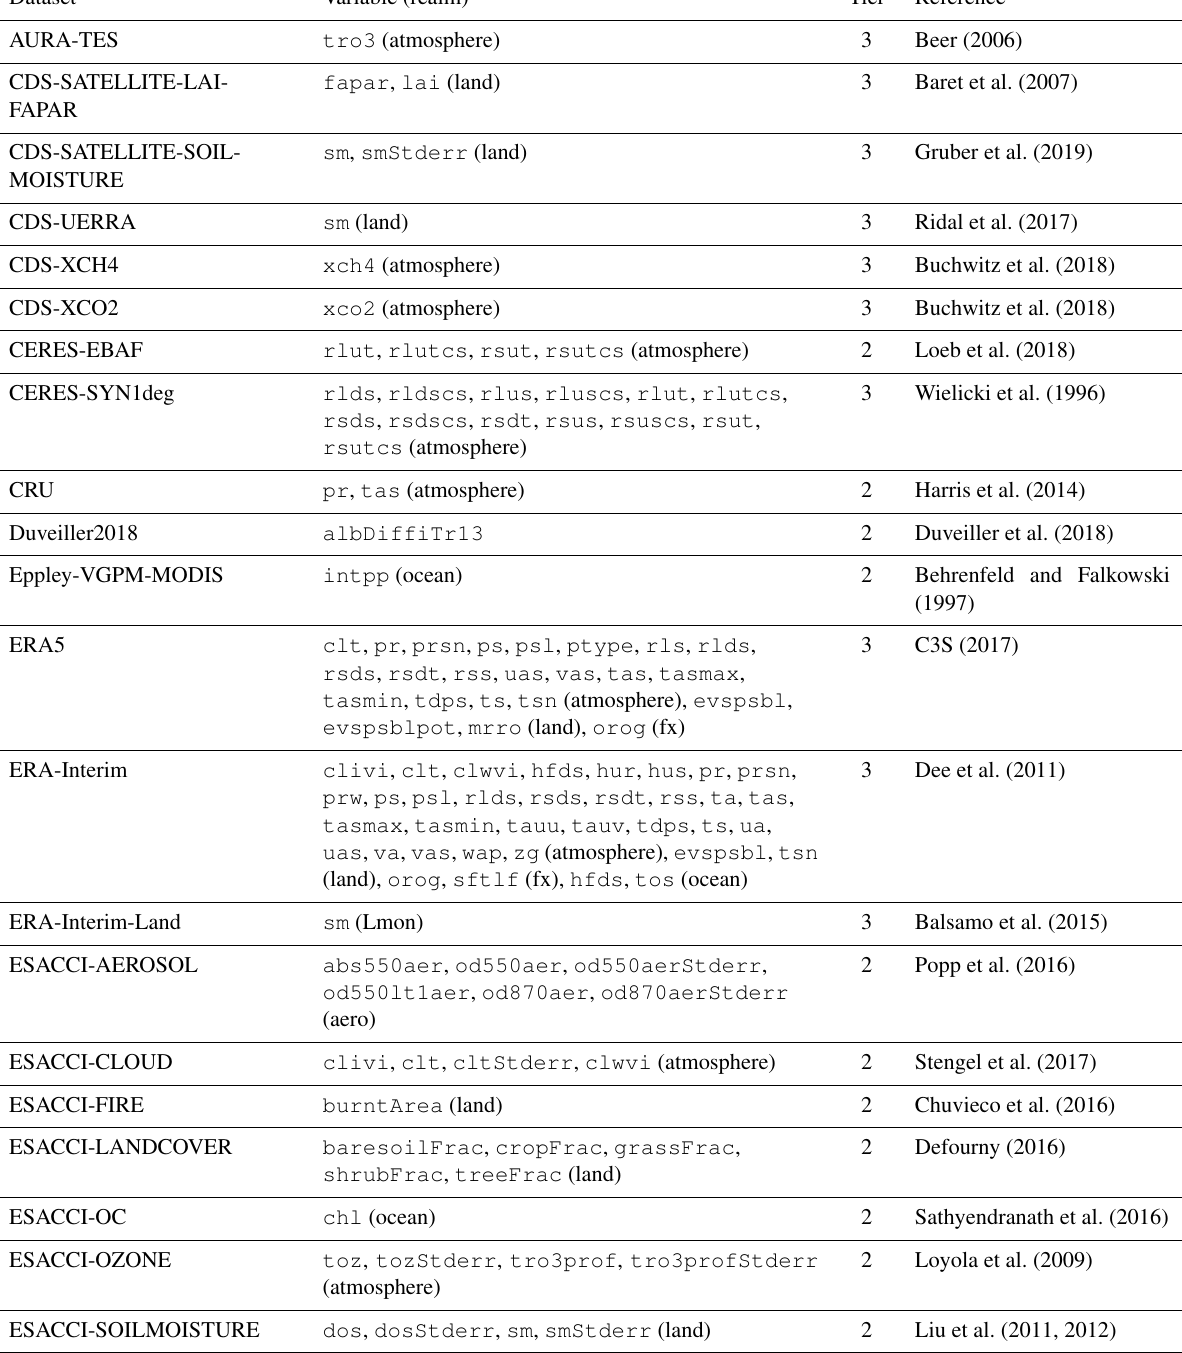
Table 3. List of the observational and reanalysis datasets for which a CMORizing script is available in ESMValTool v2.0, together with the corresponding variables (realms), tier level and